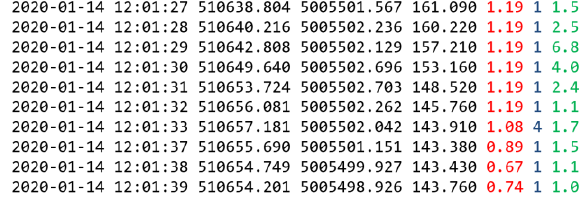
Figure 16. Excerpt from the stored tracks data